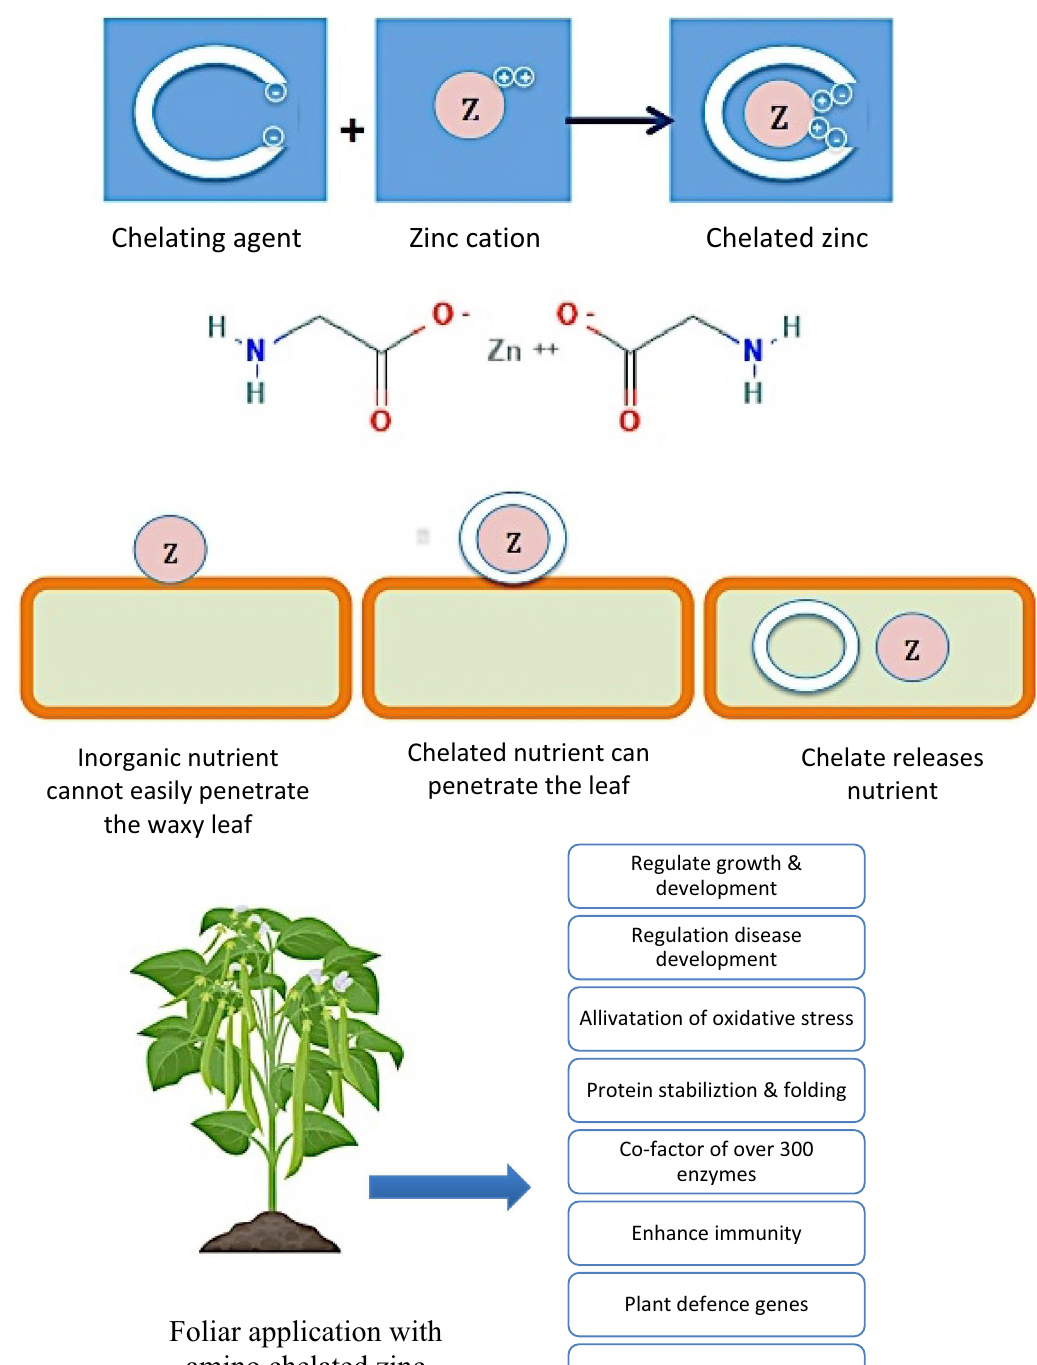
Figure 5. Diagram for chelation mechanism of zinc. Waxy leaves repels inorganic substances nutrient to penetrate into leaf. The organic coating around the chelated nutrient allows it to penetrate through the